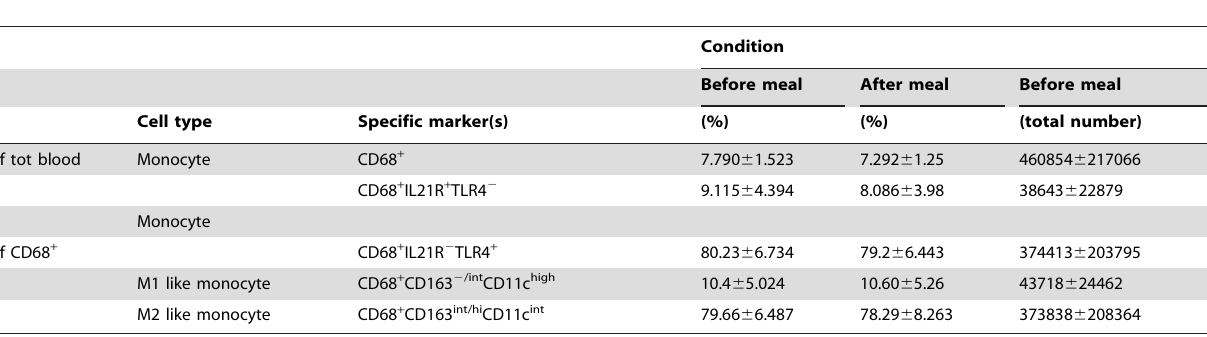
Table 2. Monocytes in peripheral blood. Data is displayed as mean 6 standard deviation.